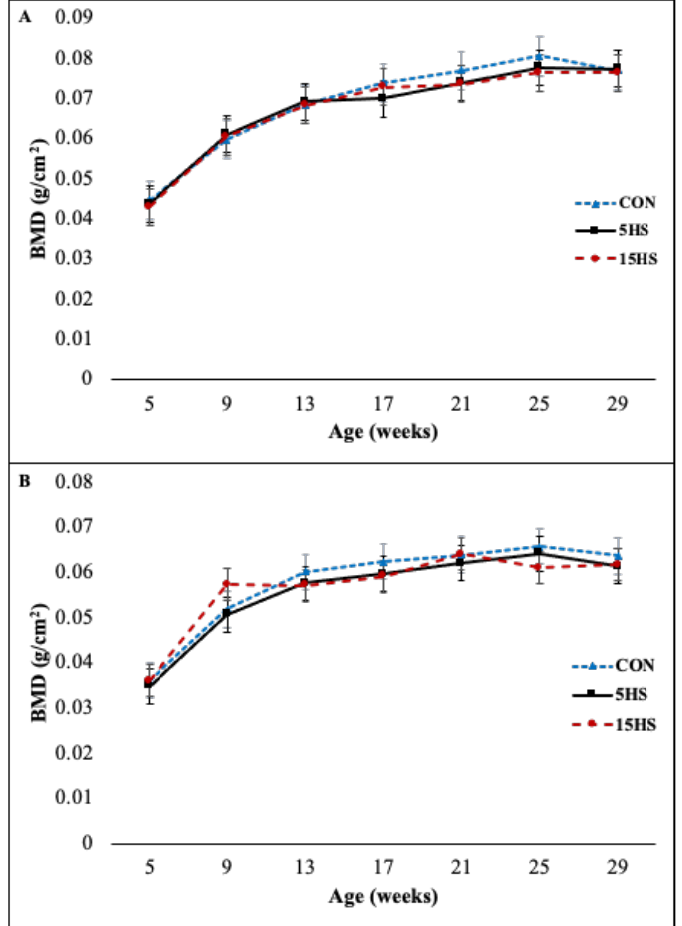
Figure 5. BMD of the right femur ( A ) and L5 vertebrae ( B ) with respect to age and diet group. Points represent mean BMD within a diet group and bars represent SEM of BMD within a diet group. Table 3. Micro-architectural parameters of right femur cortical bone (Ct.Th & Ct.Ar/Tt.Ar) and